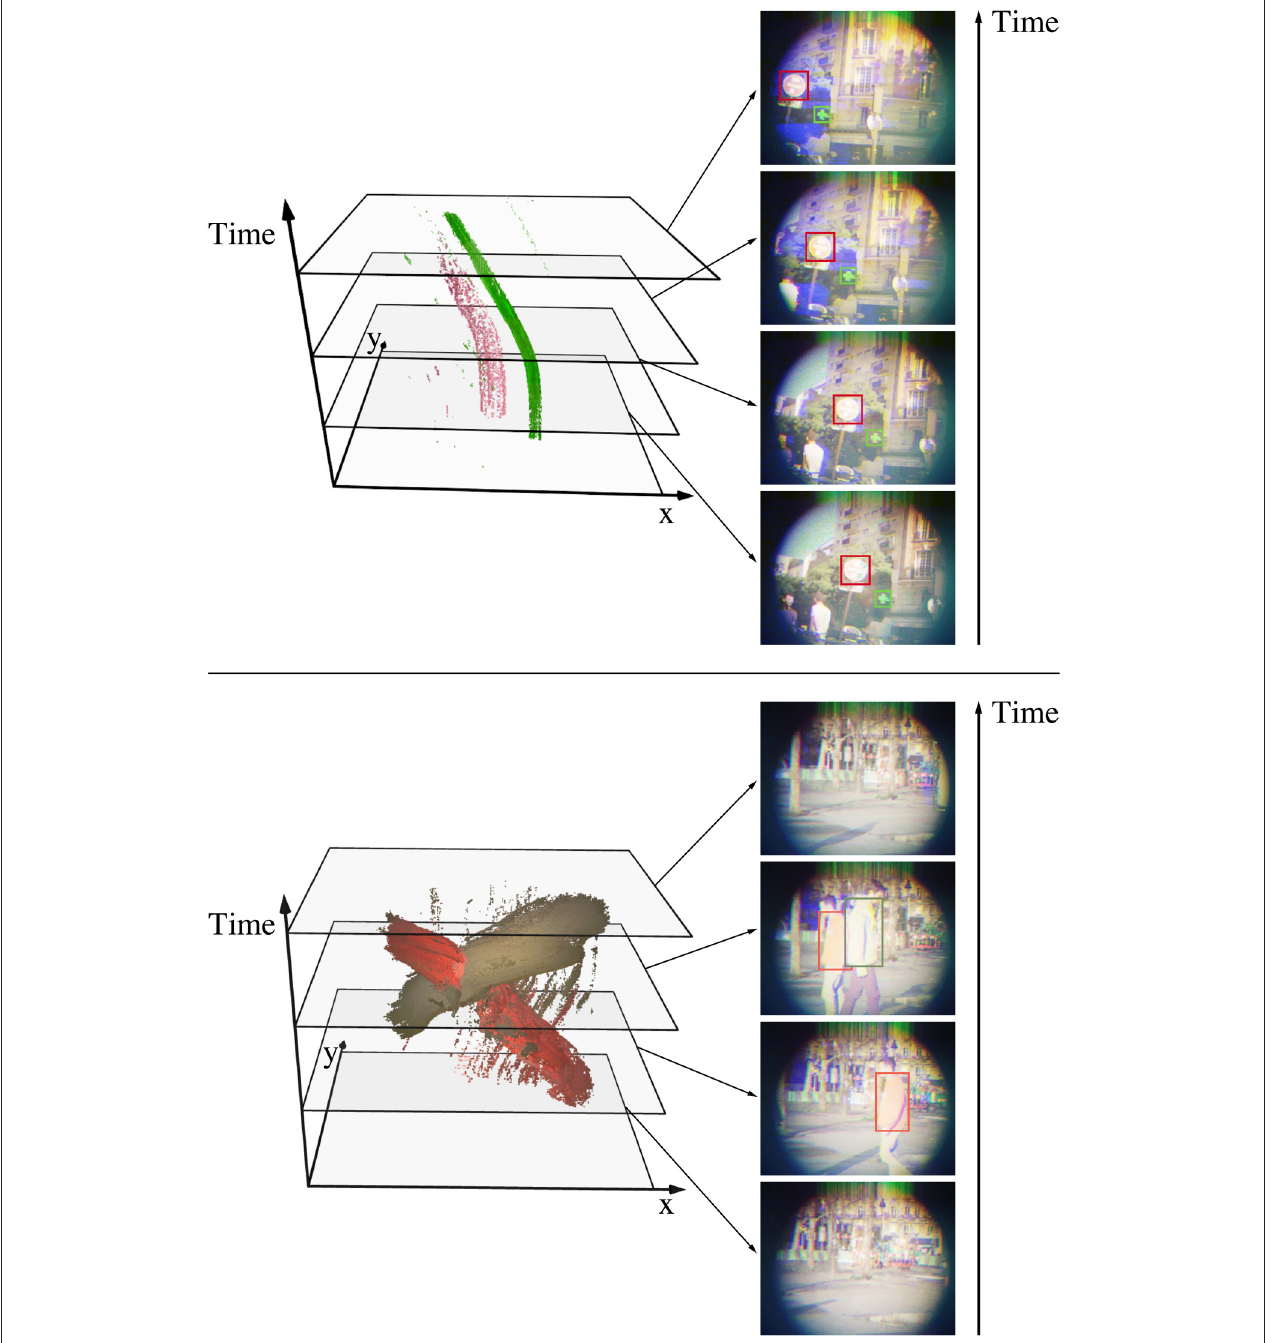
FIGURE 9 | We consider two outdoors scenes to assess the tracking algorithm performance: a moving camera acquiring a red road sign and a green pharmacy sign (Top) , and a static camera recording pedestrians wearing colored sweaters (Bottom) . The color signatures for the objects are calculated from similar scenes. The point clouds show color events where f O is larger than 10 − 5 for one of the objects. These events are used to update the estimated center of the associated object with a moving mean algorithm where λ = 1 − 10 − 3 . The tracked object are framed on the reconstructed frames for better visualization.